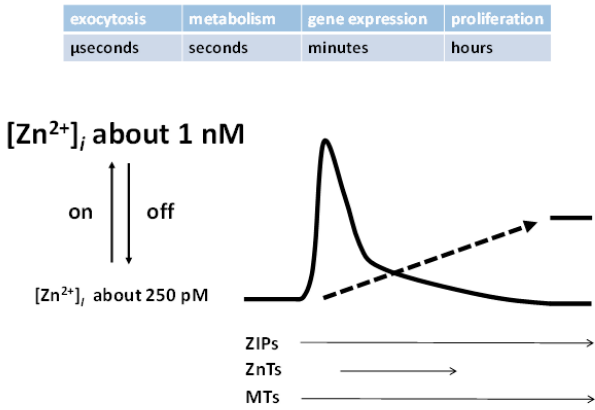
Figure 3. Cellular zinc transients and their control. Several pathways generate rapid zinc transients (zinc signals) with biological responses on various time scales. The amplitude of these zinc signals is about a few nanomolar globally, from picomolar basal “free” zinc ion concentrations, but may be higher in microdomains. Proteins involved in the control of zinc homeostasis serve as mufflers (ZIPs, ZnTs) and buffers (MTs) to restore the steady-state. A much slower process (arrow) leads to an overall change of the zinc-buffering characteristics of the cell, establishing different basal levels of “free” zinc ion concentrations.